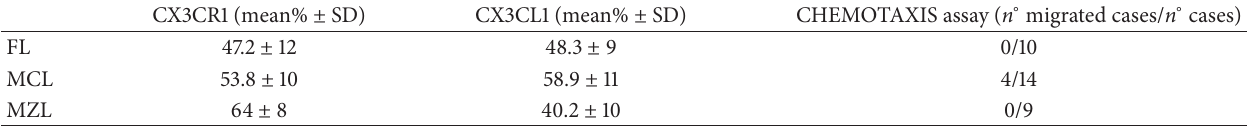
Table 2: Expression and function of CX3CL1/CX3CR1 axis in human B cell lymphomas.